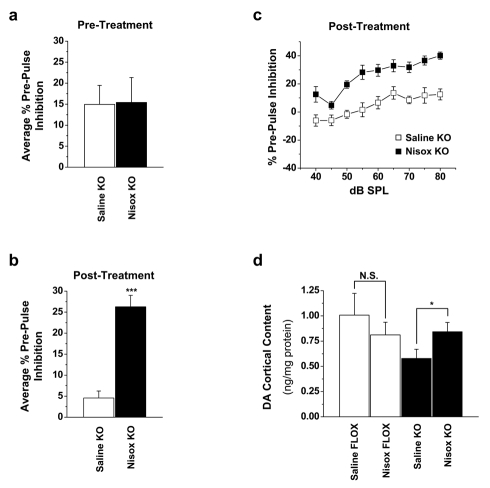
Nisoxetine restores PPI deficits and DA levels in the rostral cortex of rictor KO mice.(A) No differences are observed in the average %PPI across the experimental range of dB in KO mice prior to treatment with saline or nisoxetine. (B) Average %PPI 30 min after i.p. injection of either saline or nisoxetine (30 mg/kg) in KO mice reveals a significant increase in %PPI in nisoxetine treated KO mice. (C) The mean PPI across all sound levels in KO mice treated with either saline or nisoxetine for 30 min; n = 5–6, ***p<0.001 Student's t test. (D) 8 d of nisoxetine treatment restores DA levels in the rostral cortex of rictor KO mice; n = 4–6. *p<0.05 Student's t test.